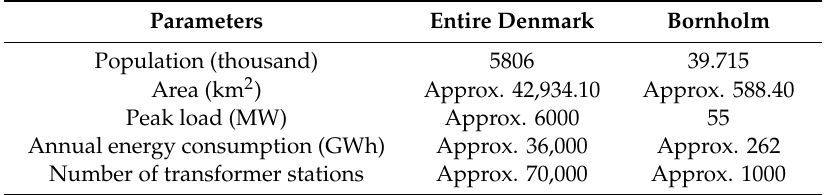
Table 1. The comparison between the entirety of Denmark and